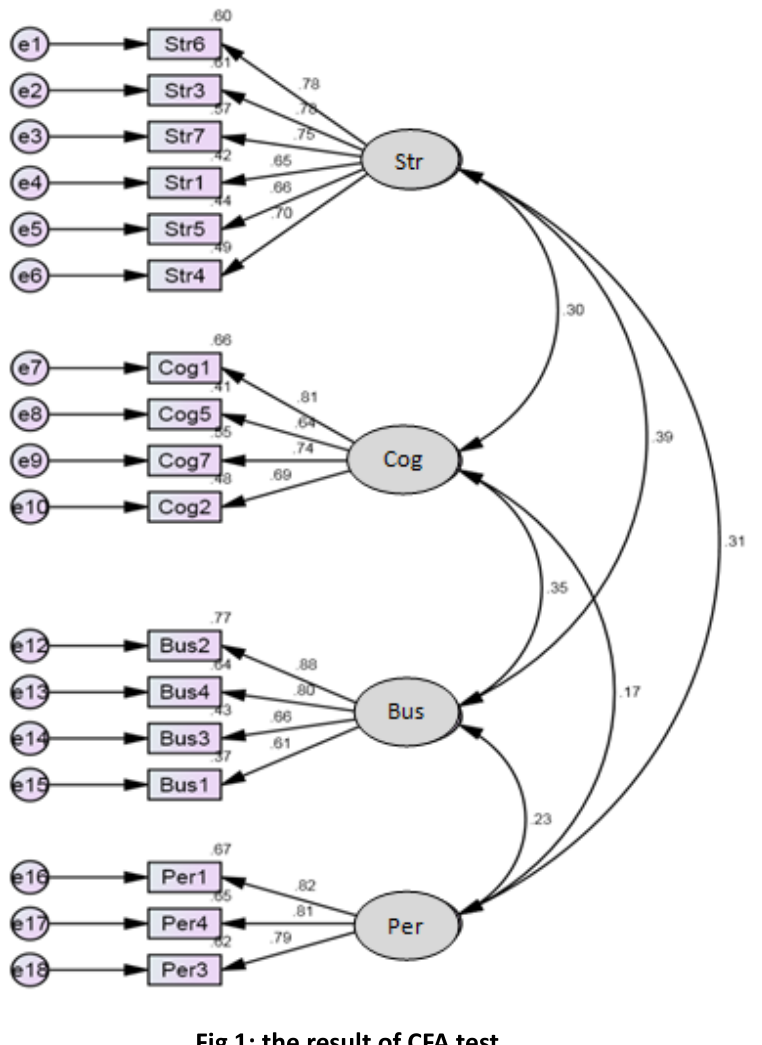
Fig 1: the result of CFA